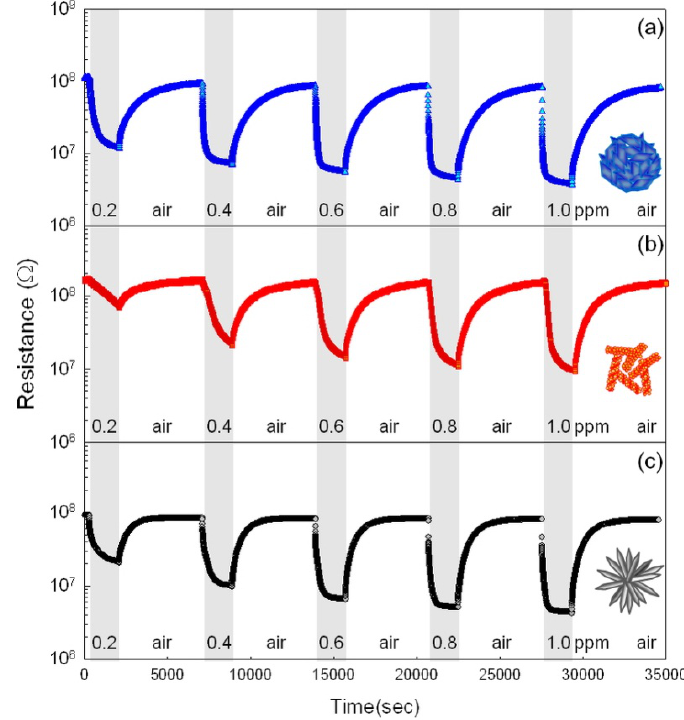
Figure 6. C H OH sensing transients of ( a ) H-NS sensor; ( b ) NR sensor; and ( c ) H-NR 2 5 sensor at 340 °C. (C H OH concentration: 0.2–1 ppm). 2 5